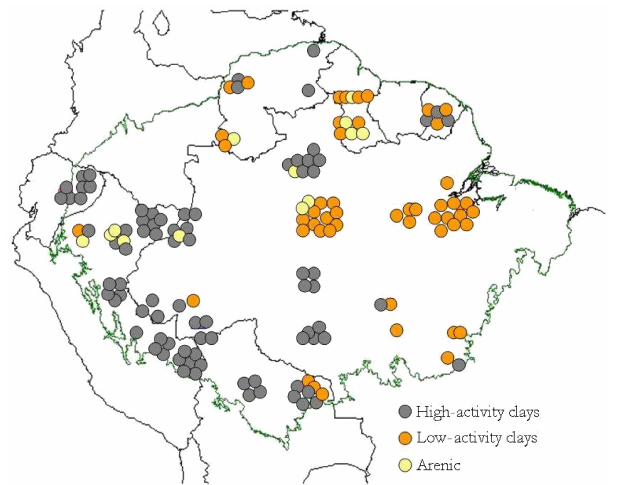
Figure 1. Geographic distribution of 147 study sites across the Amazon Basin, according to the different soil groups. Each point is a 1ha forest inventory permanent plot. Geographical locations have been manipulated in the map to allow visualisation of site clusters at this